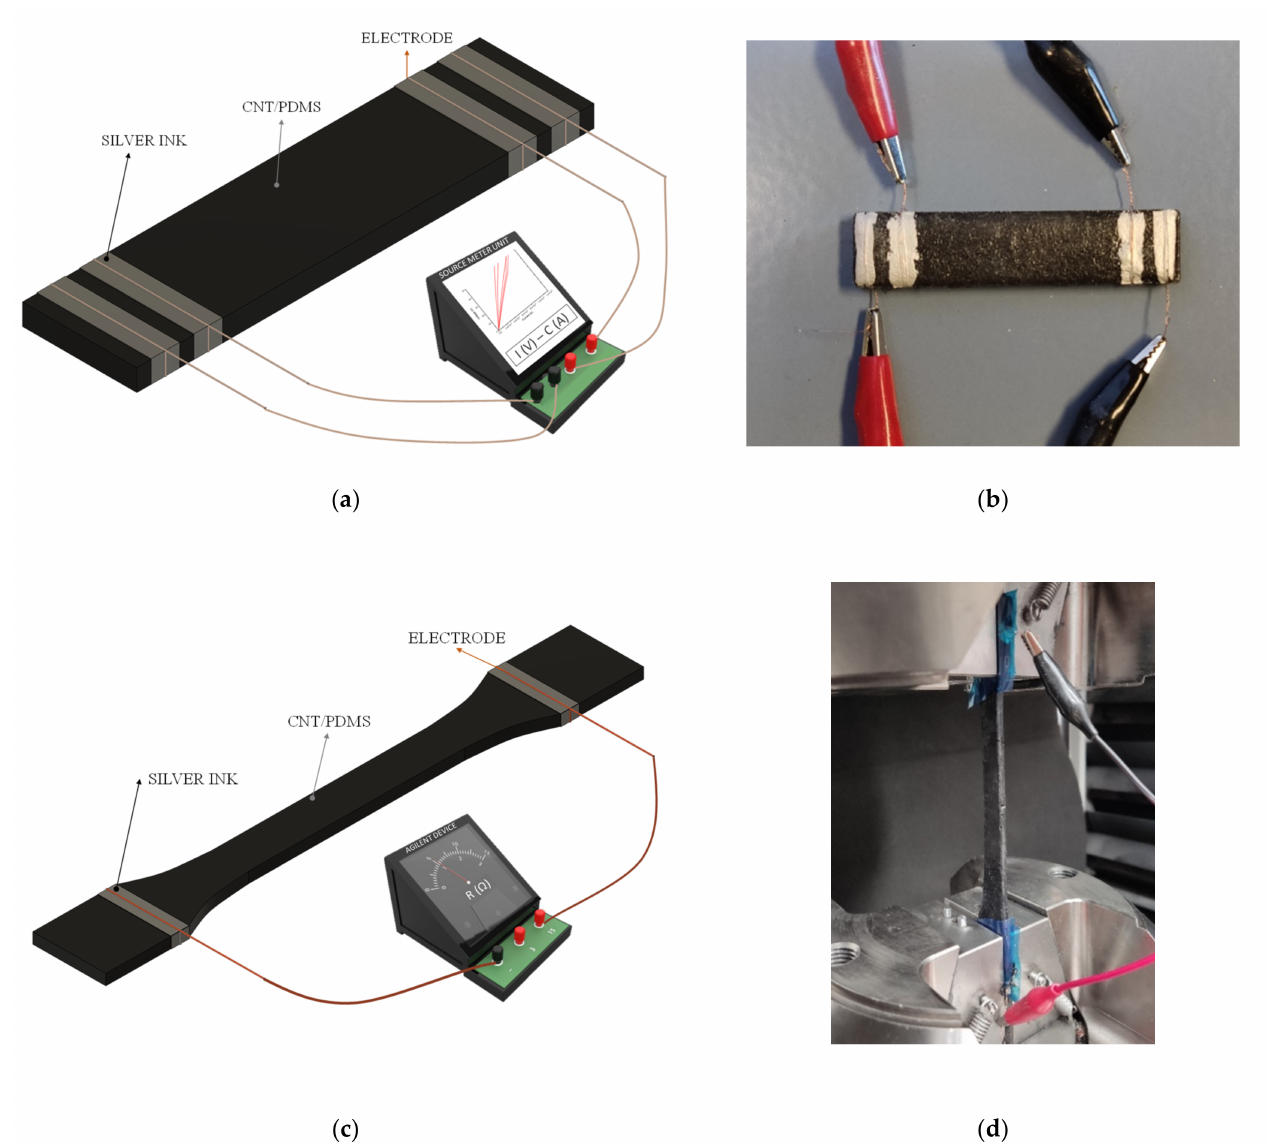
Figure 1. Scheme and real specimens for ( a , b ) electrical conductivity and ( c , d ) electromechanical